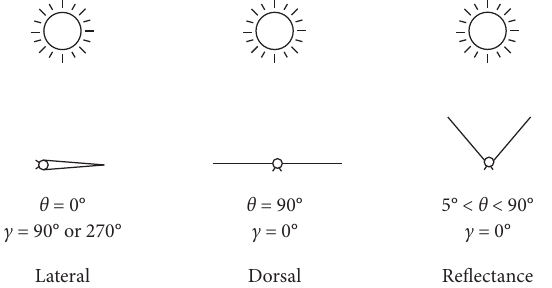
Figure 7: Basking postures: lateral, dorsal, and reflectance used by butterflies